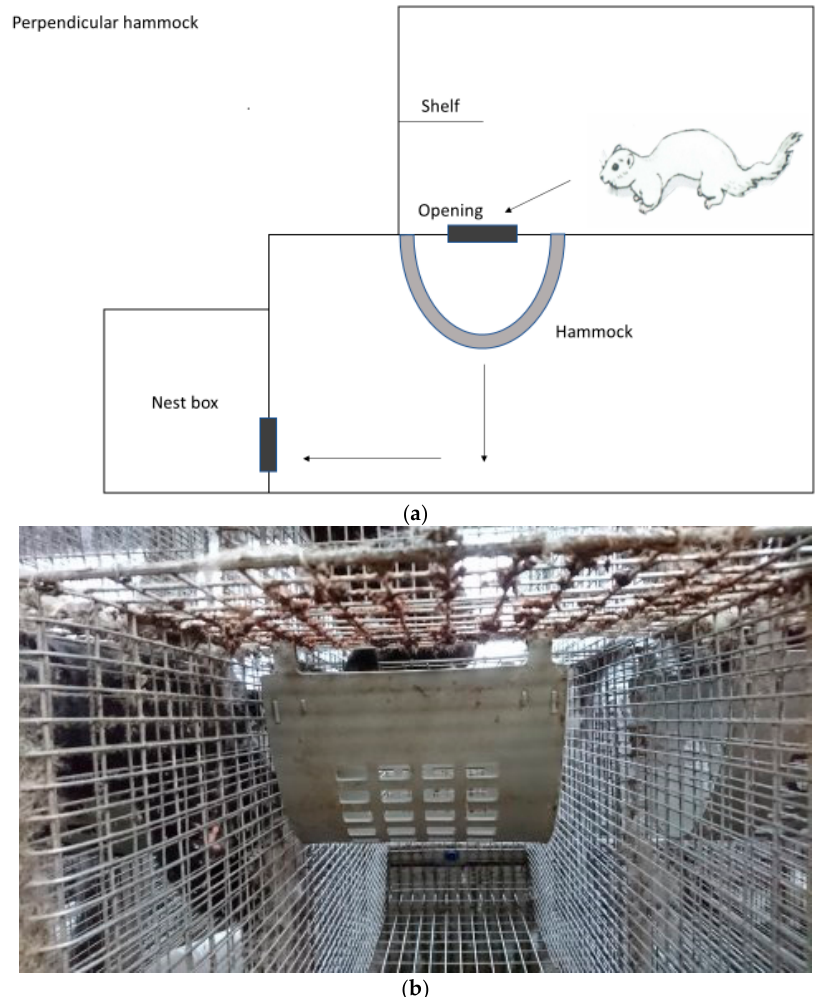
Figure 2. ( a ) Multilevel cage with a hammock installed perpendicular to the sidewalls, view from the left side. The arrows indicate the chosen route of the mink from the upper floor to the nest box. ( b ) Front view of a hammock placed perpendicular to the sidewalls. A chi-square test was used to test for independence between the farm and proportion of wounds. Fisher’s exact test was used to test for differences in occurrence of tail tip lesions between groups with and without a hammock. The analyses were carried out in SPSS (IBM Corp. IBM SPSS Statistics for MAC, Version 25. Armonk, NY: IBM Corp, USA).